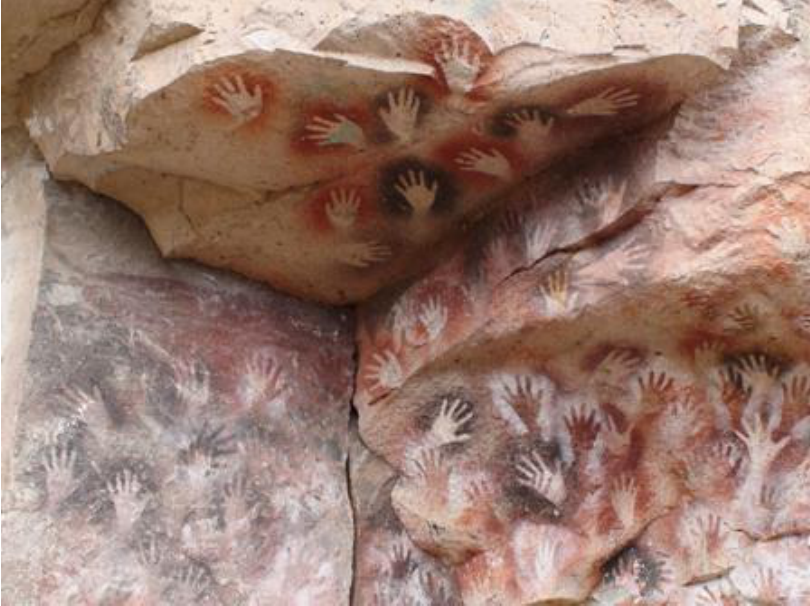
Figure 6. Cueva de las Manos, Santa Cruz,